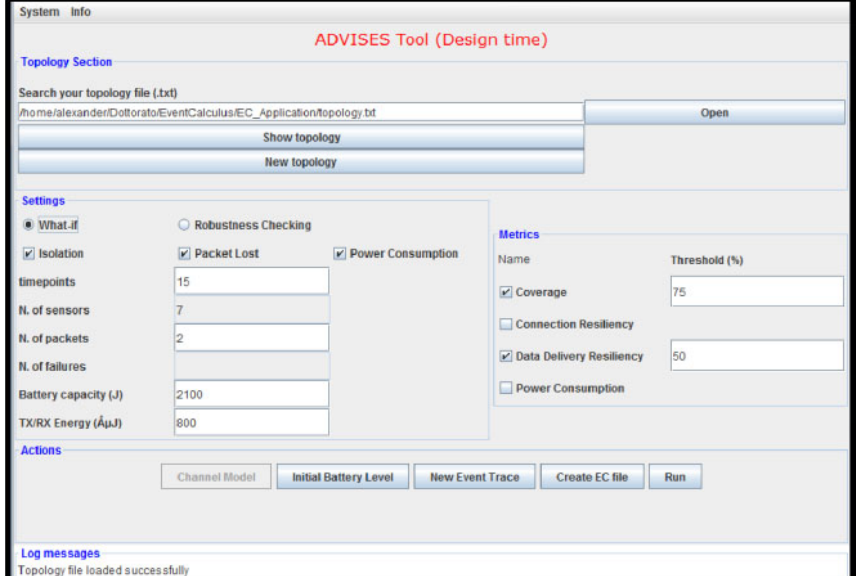
Figure 6. Outcome of ADVISES in static mode running. Parameters for What-if analysis and Robustness Checking computing are